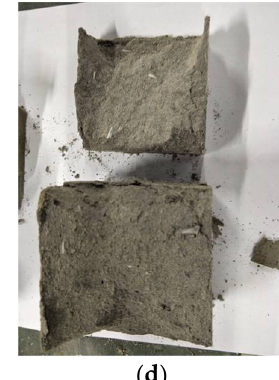
Figure 11. Comparison of the doped and undoped shotcrete specimens. Size of specimen is 7.07 × 7.07 × 7.07 cm 3 : ( a ) Photo of the undoped specimen. ( b ) Interior of the undoped specimen. ( c ) Photo of the doped specimen ( d ) Interior of the doped specimen.